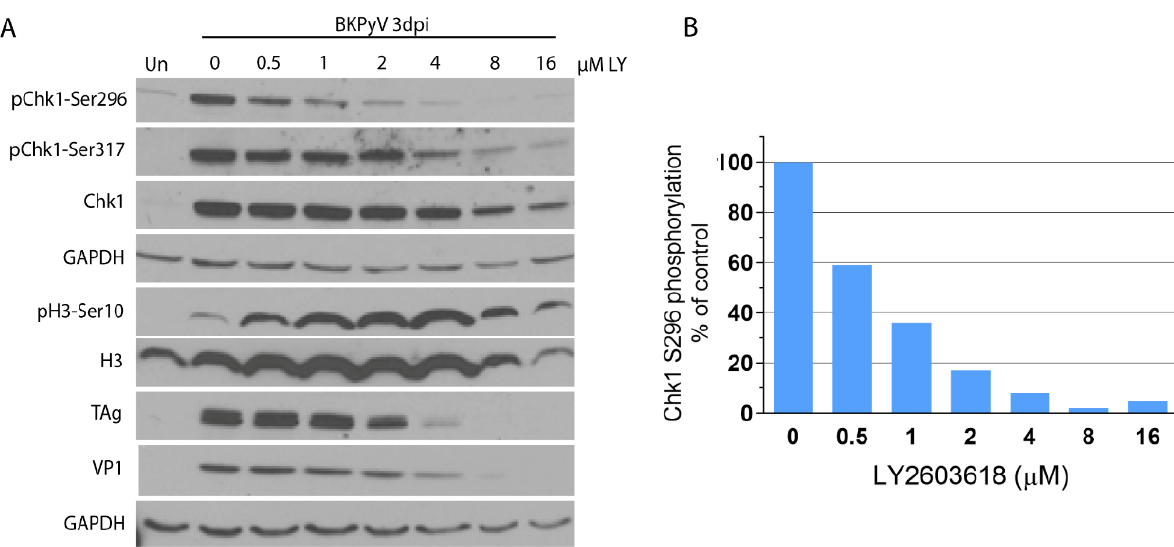
Figure 4. Concentration-dependent effects of LY2603618 on Chk1 autophosphorylation and viral protein expression. Quiescent RPTECs were infected with BKPyV Gardner (MOI = 10 IU/cell) for 1.5 h and incubated in the indicated LY2603618 concentrations for three days. Uninfected cells (Un) serve as a negative control. ( A ) Cells were harvested at 3 dpi by lysis with SDS-PAGE sample buffer and analyzed by immunoblotting with the indicated antibodies; representative of n = 4. ( B ) Band intensity of pChk1-Ser296, the Chk1 autophosphorylation site, was normalized to intensity of the total Chk1 band and presented as percent of untreated, BKPyV-infected control. An IC50 = 640 nM was calculated with GraphPad prism.